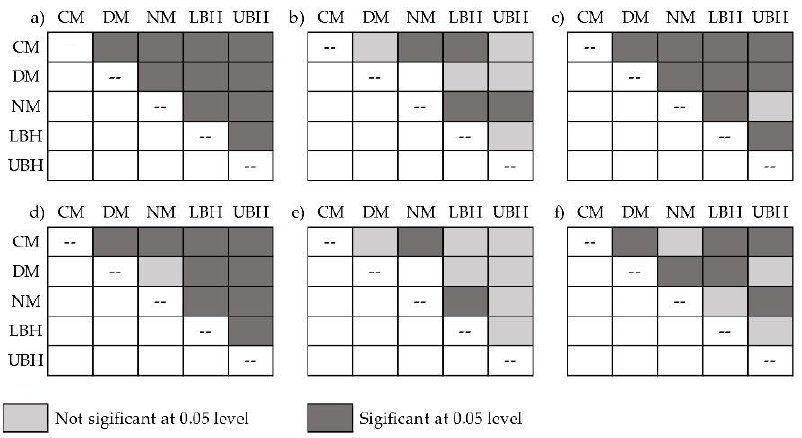
Figure 9. Matrices showing statistically significant and insignificant differences in harvest area spectral recovery metrics between Subregions of the Boreal Forest Region, including ( a ) NBR preDistb , ( b ) Harvest yr , ( c ) NBR totDistb , ( d ) Recov% 5yr , ( e ) Y2R, and ( f ) Recov% endTS .